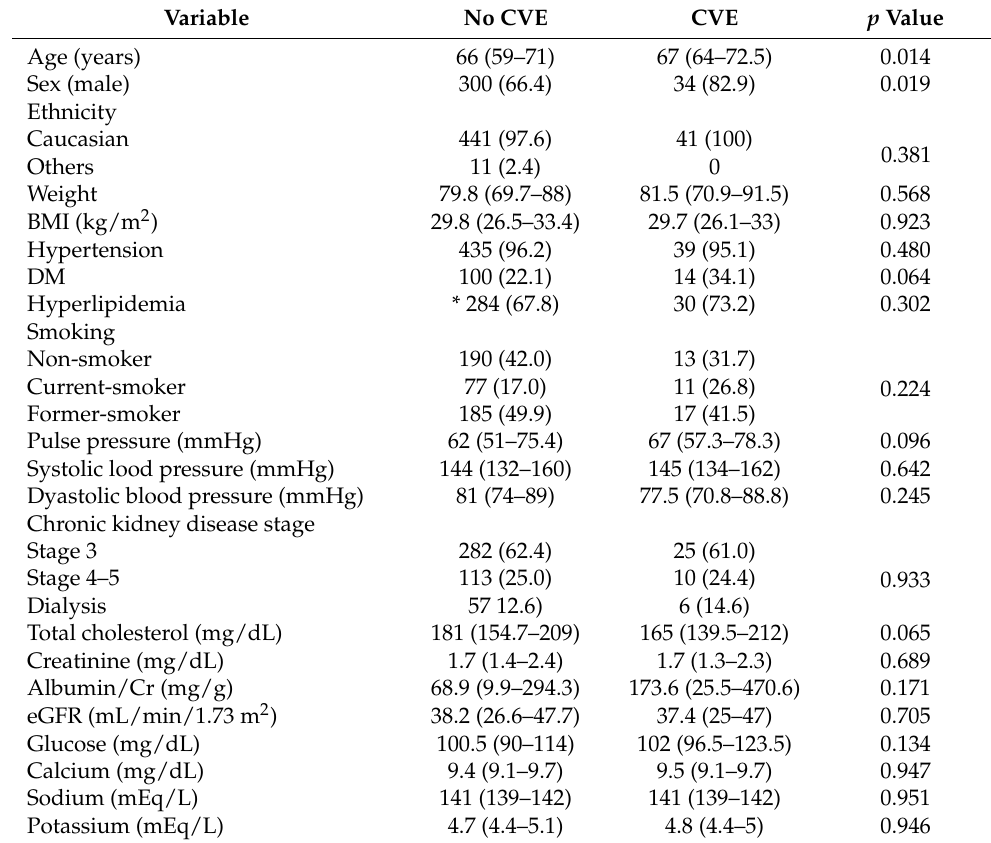
Table 4. Parameters of interest in nephrosclerosis patients experiencing or not cardiovascular events. Median (range) or count (percentages) are